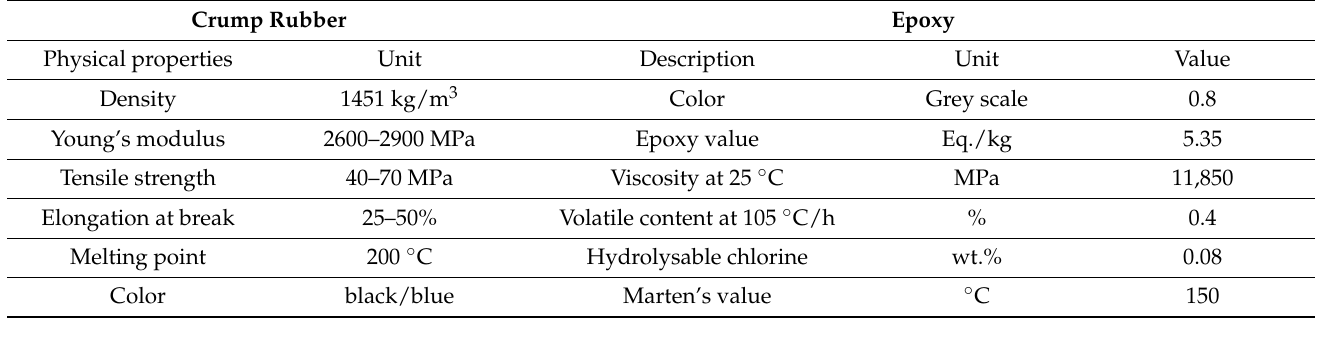
Table 1. Properties of crump rubber and epoxy matrix.